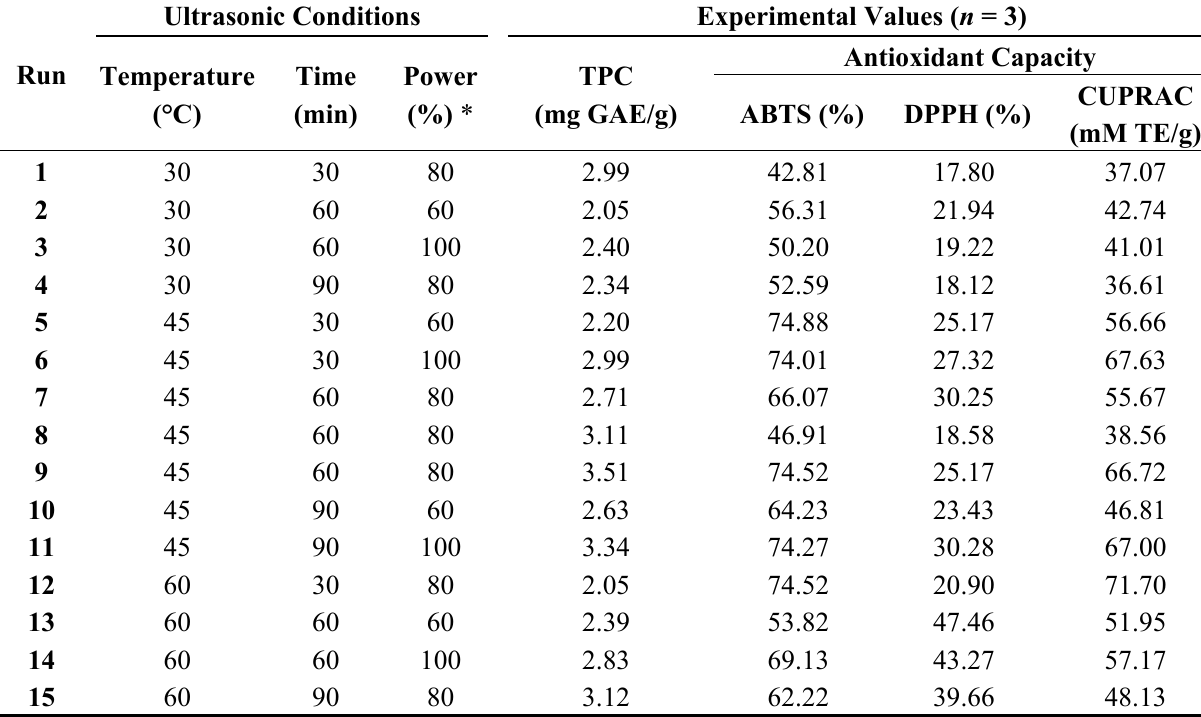
Table 1. Box-Behnken design and observed